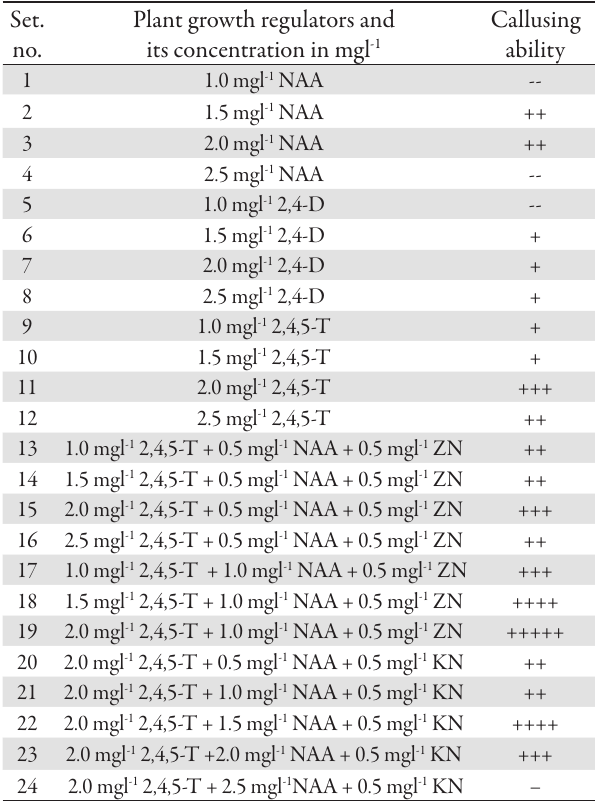
Tab. 1. Effect of different plant growth regulators on callusing ability**